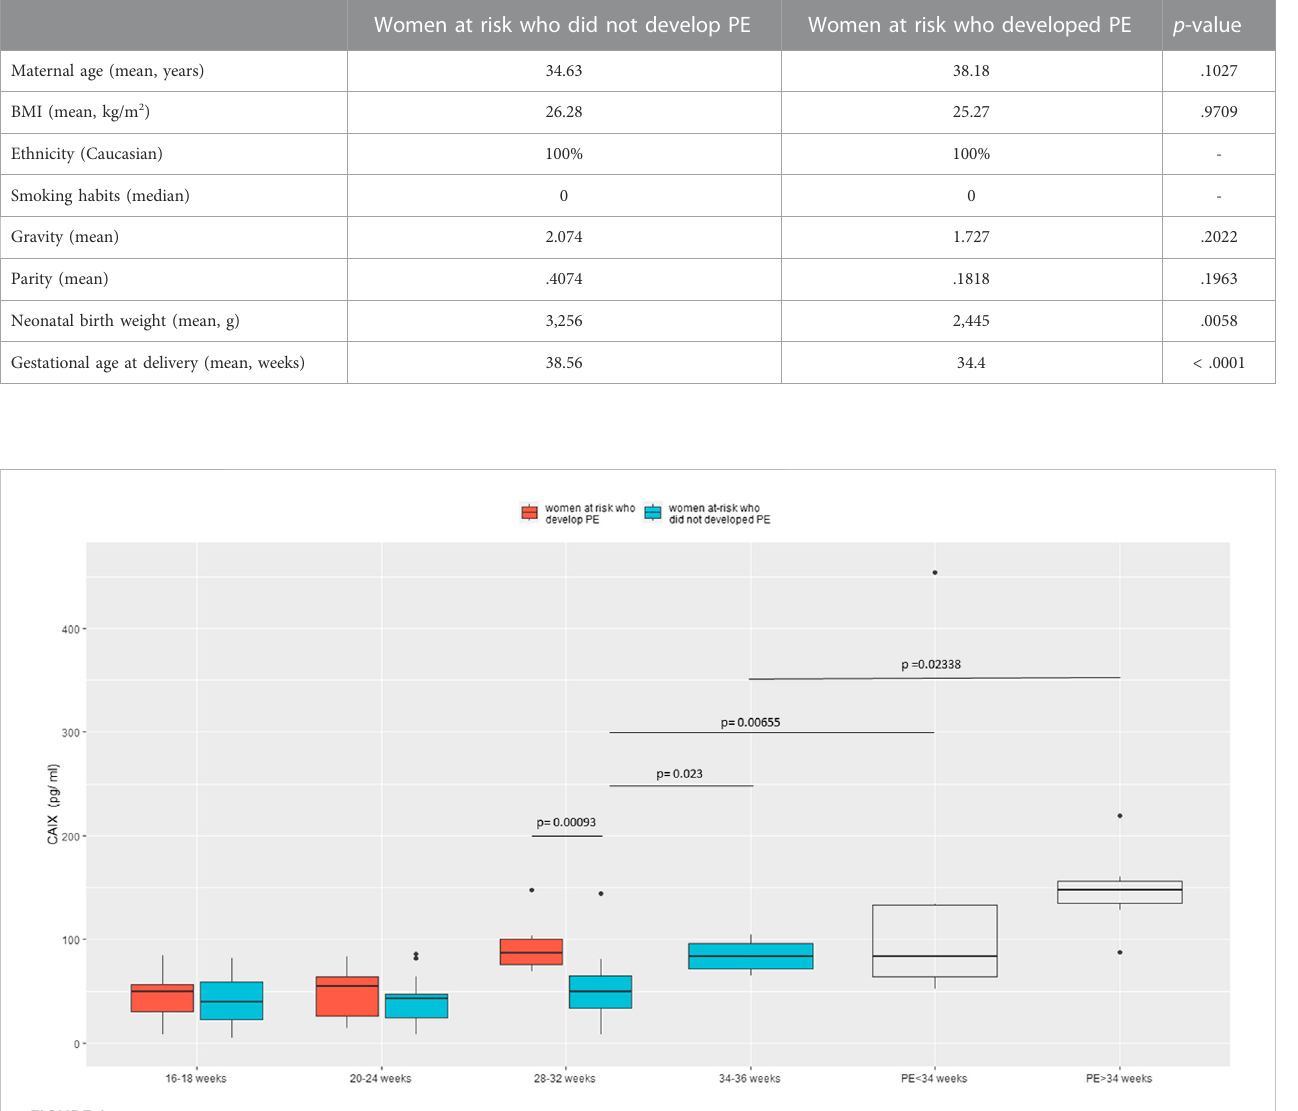
FIGURE 1 Boxplots comparing CAIXlevels inwomenatriskwhoweresubsequentlydiagnosedas PE(red)and thosewhowerenot (light blue) sampledatdifferent gestational ages and women with the early ( n = 8) or late ( n = 7) overt PE (white). 16 – 18 gestational weeks: n = 7 women at risk who developed PE and n = 16womenatriskwhodidnotdevelopPE;20 – 24gestationalweeks: n =6womenatriskwhodevelopedPEand n